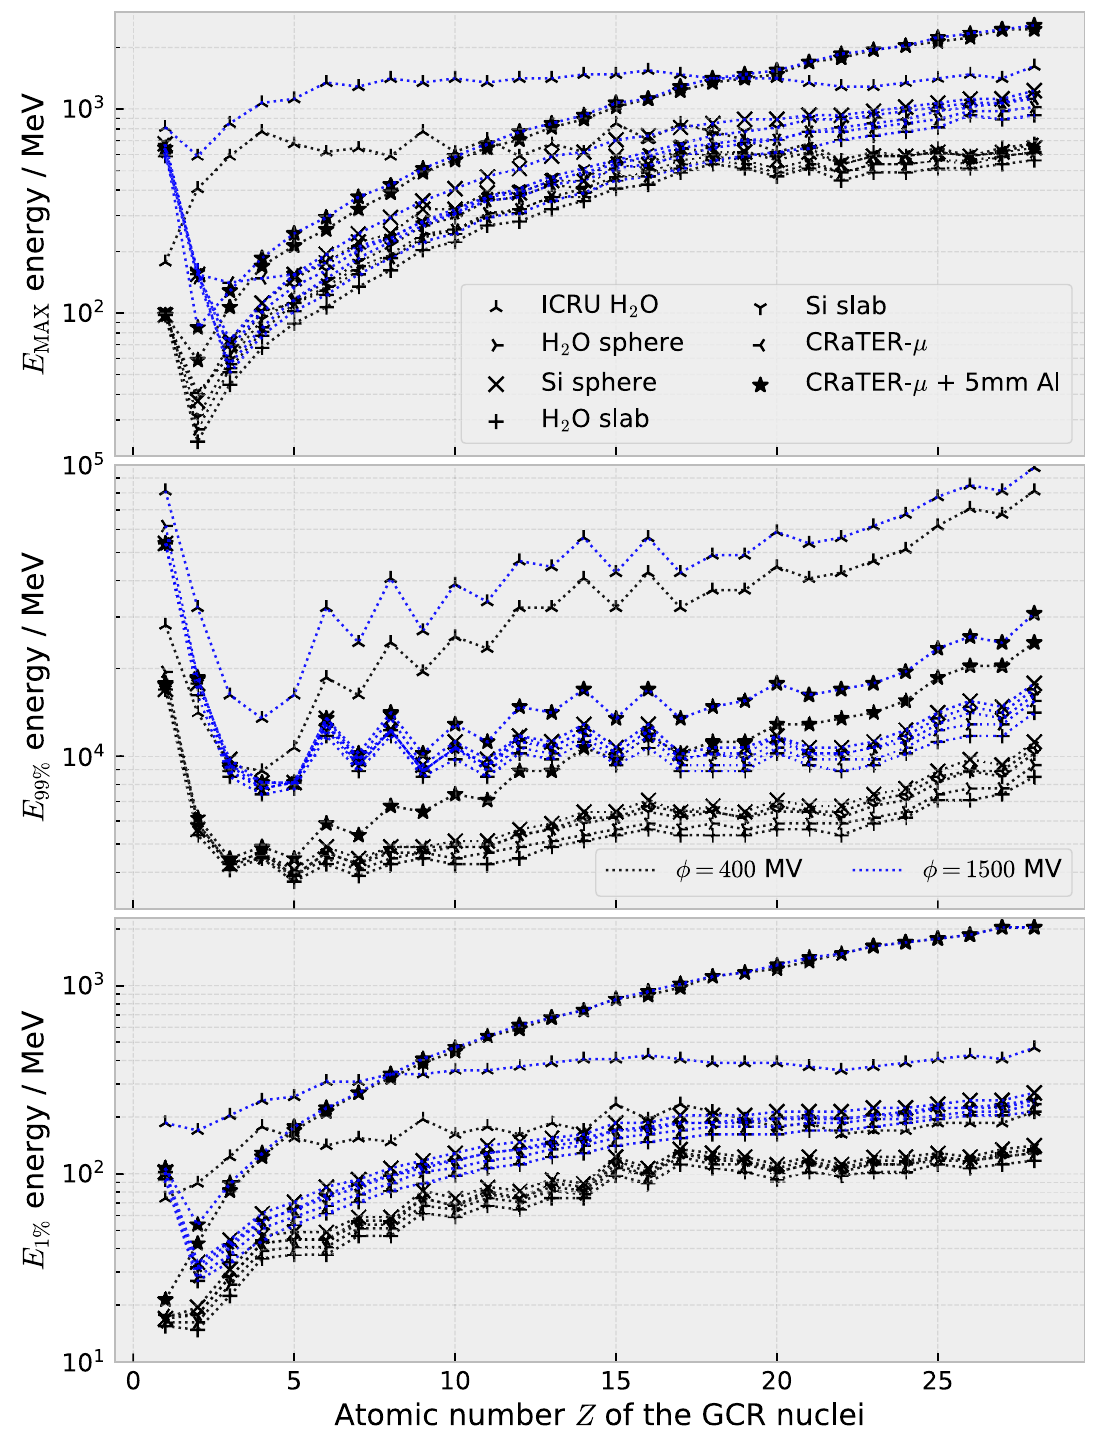
Fig. A3. In order to characterize the signi fi cant energy range for each GCR nucleus, we have calculated the most harmful kinetic energy (top panel), the kinetic energy required to achieve 99% of the net absorbed dose rate (middle panel) and the kinetic energy required to achieve 1%. Each panel contains 14 scatter graphs corresponding to the seven phantoms indicated with different symbols and two levels of solar activity, indicated with two colors. For example, crosses with blue lines are for the H 2 O slab at solar maximum ( / = 1500 MV). Limiting our simulation to the energy range [ E 1% , E 99% ] would result in a underestimation ofthe absorbed dose rate of the order of 2%. Important data presented here has been summarized in Table